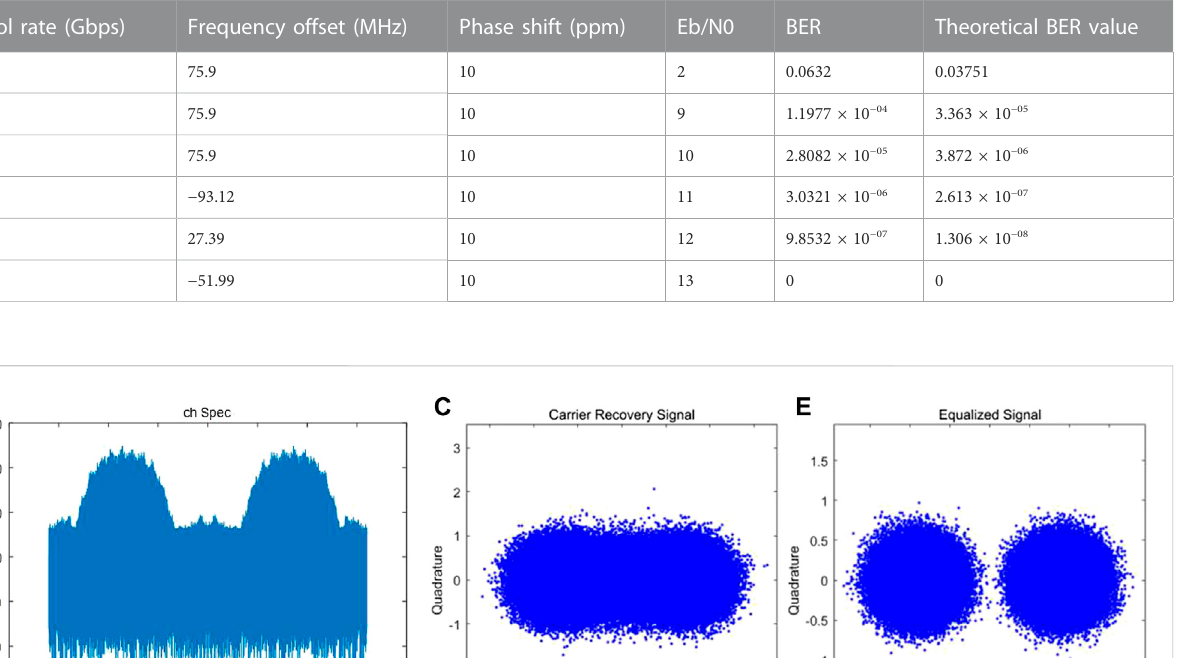
TABLE 2 Simulation